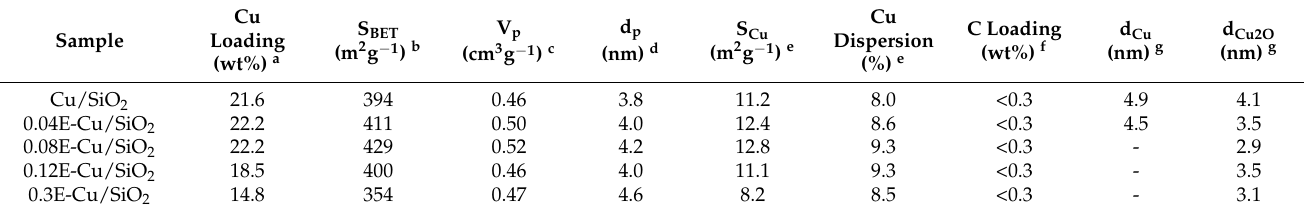
Table 1. Physical and chemical properties of xE-Cu/SiO 2 catalysts.